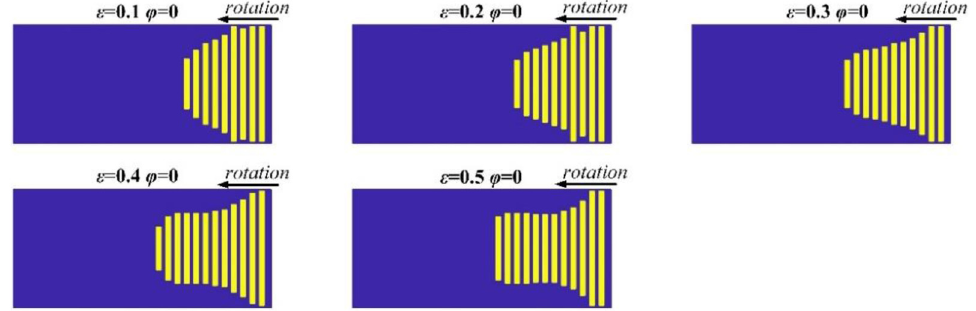
Fig. 12. The optimal groove textures under e =0.1 – 0.5, ’ = 0, N =